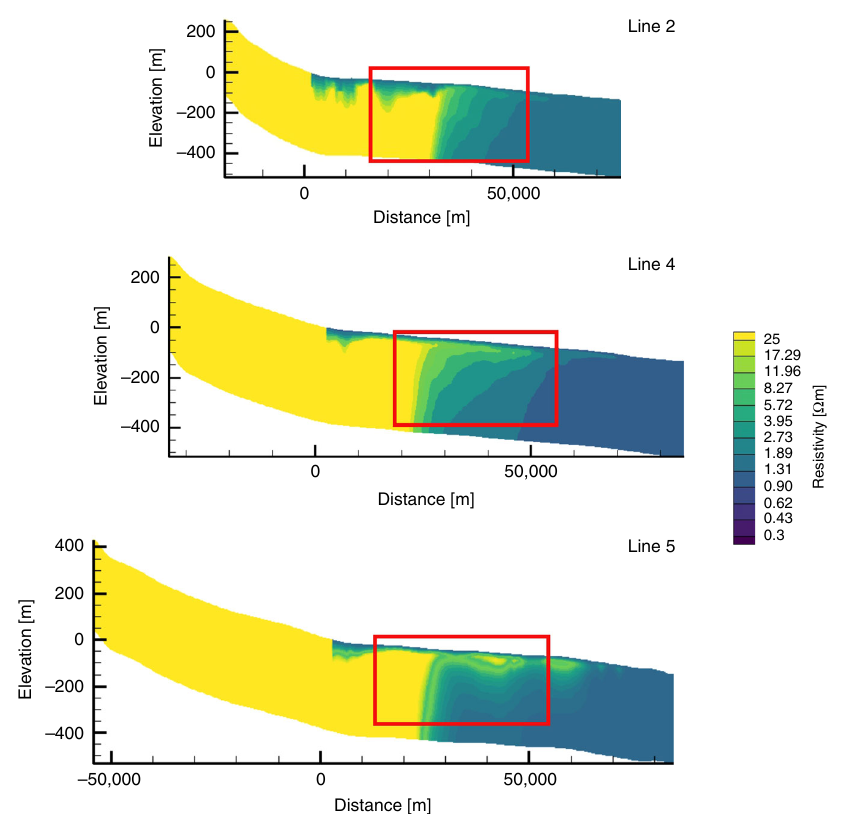
Fig. 8 Fluid resistivity pro fi les computed from the hydrological model results in Fig. 7d – f. Distance refers to the shore-normal direction. The present-day shoreline is located at x = 0 km, with negative values of distance referencing the onshore